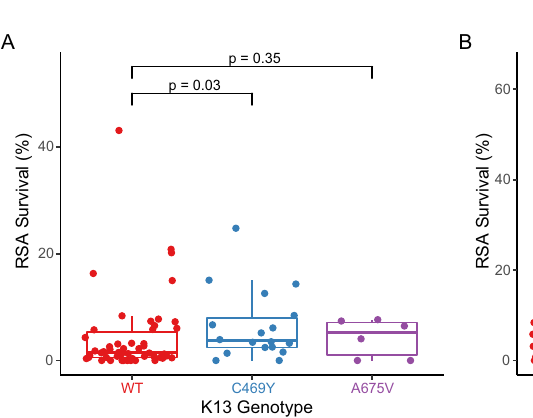
Fig. 2 | Ex vivo susceptibilities. Susceptibilities to lumefantrine ( A growth inhi- bitionassay)andDHA( B RSA)inparasitesfromnorthernandeasternUganda.Each point represents the result for a single isolate ( A n =49 for northern and 38 for eastern Uganda; B n =52 for northern and 29 for eastern Uganda). P -values were determined using the two-sided Mann – Whitney Wilcoxon test. Center bounds of